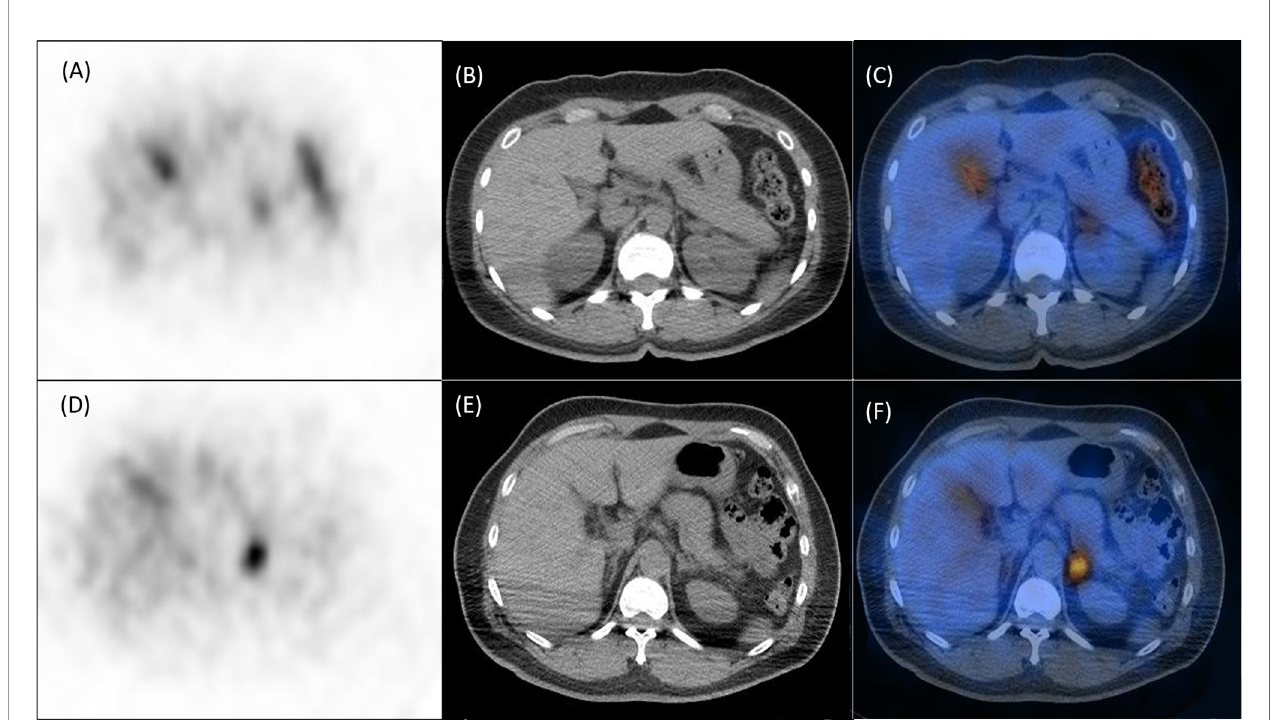
FIGURE 3 | Representative NP-59 adrenal SPECT/CT and KCNJ5 mutation status. Upper panel, fi ndings ofa 40-year-old femalewithout KCNJ5 mutation.SPECT (A) , CT (B) and fusion SPECT/CT (C) showedmoderate NP-59 uptake at leftadrenal glandwith ALRof2.62 andCON of 1.38. Lower panel, fi ndings of a 54-year-old malewith KCNJ5 mutation.SPECT (D) , CT (E) and fusion SPECT/CT (F) showed signi fi cant NP-59 uptake at leftadrenal glandwith ALRof3.72 andCON of 2.41.